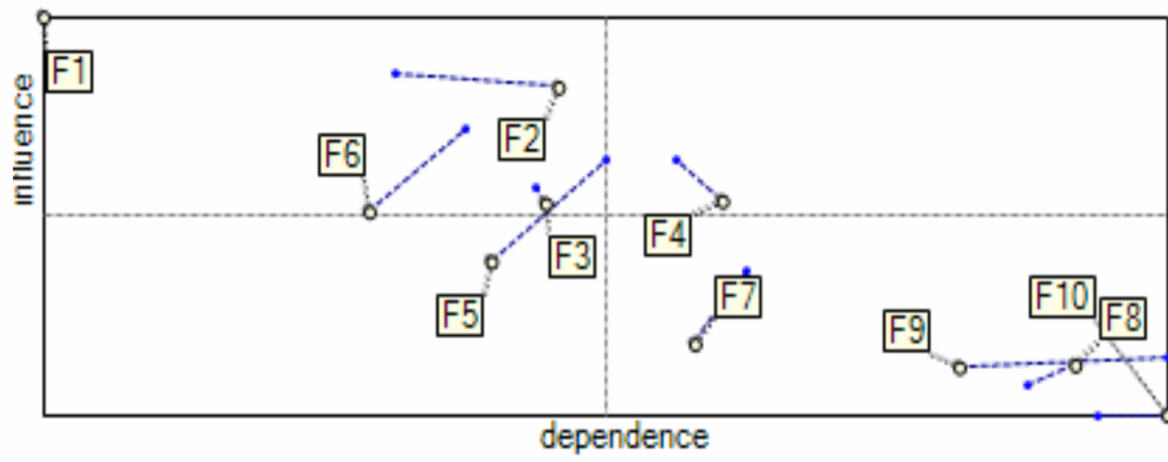
Figure 7. Displacement map (indirect to direct) for